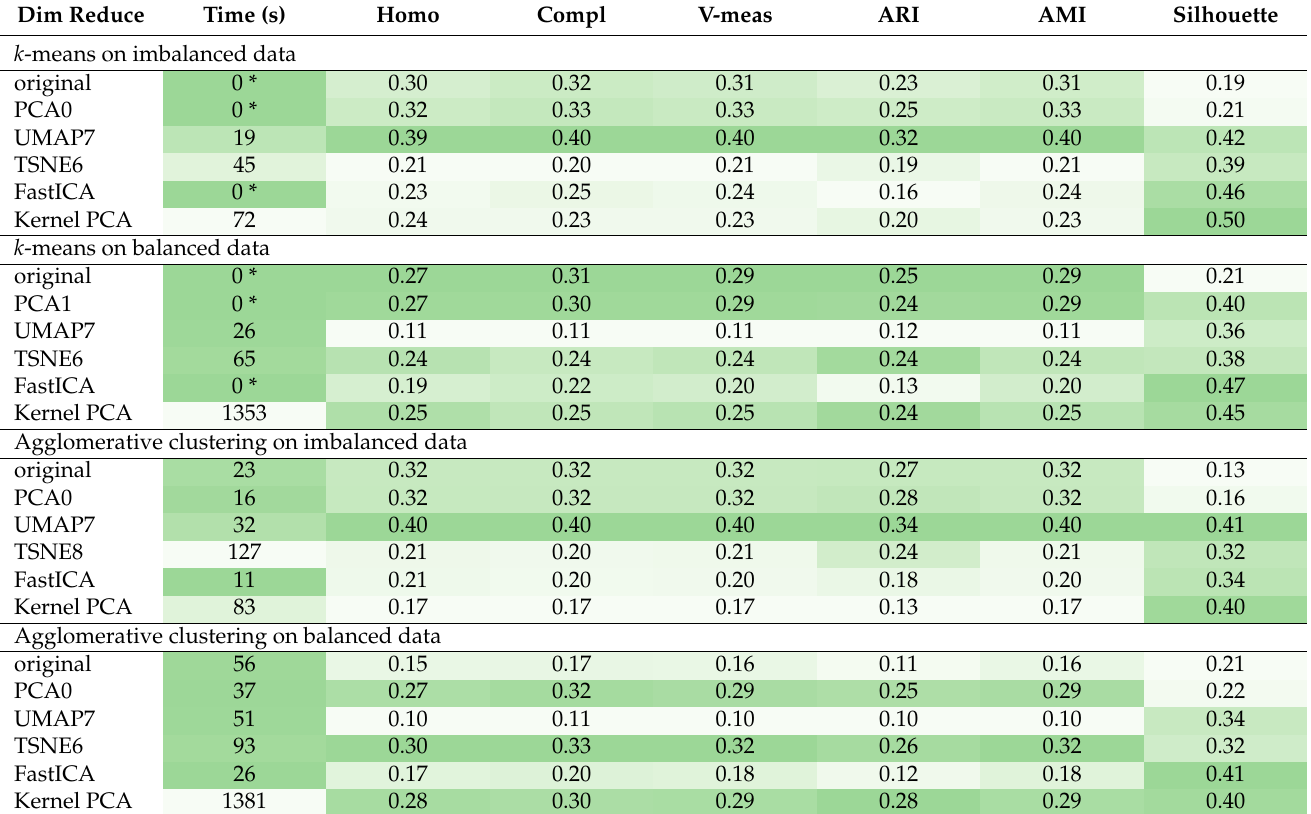
Table 1. Clustering the original terpenes data along with dimensionality-reduced form of it, in both imbalanced and balanced forms. Parameters are described in Supplementary Table S3. * Less than 1